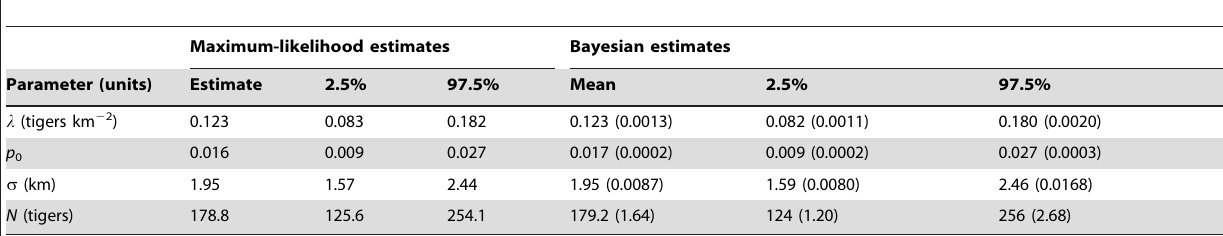
Table 2. Estimates of parameters of model fitted to recaptures of tigers at trap